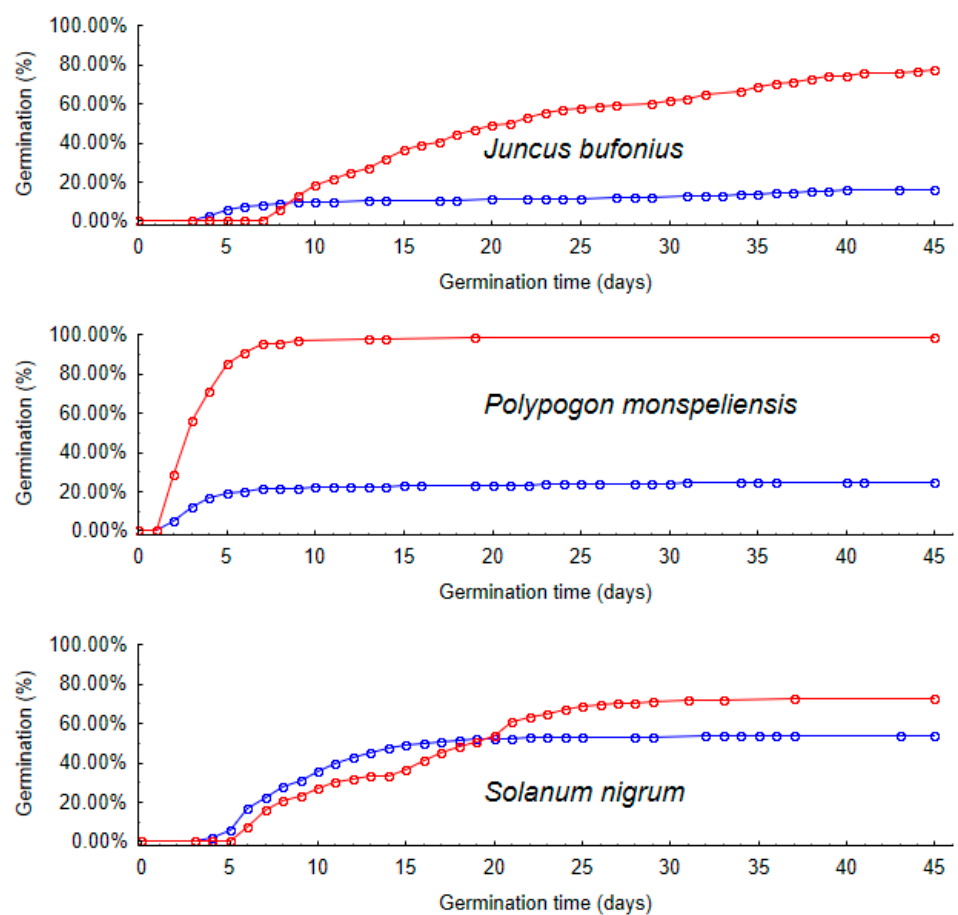
Figure 3. Accumulative percentage curve of germinated seeds of five plant species after gut passage (blue) and for control seeds (red). Table 4. Differences in germinability (percentage of seeds) after gut passage compared with control seeds. S.D.: Standard deviation. C.I.: 95% Confidence Interval.